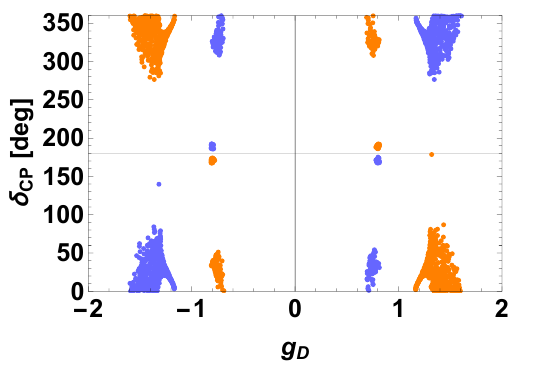
Figure 9 . The sign of Y B in the g D – δ CP plane. Orange and blue points denote positive Y B and negative Y B , respectively.